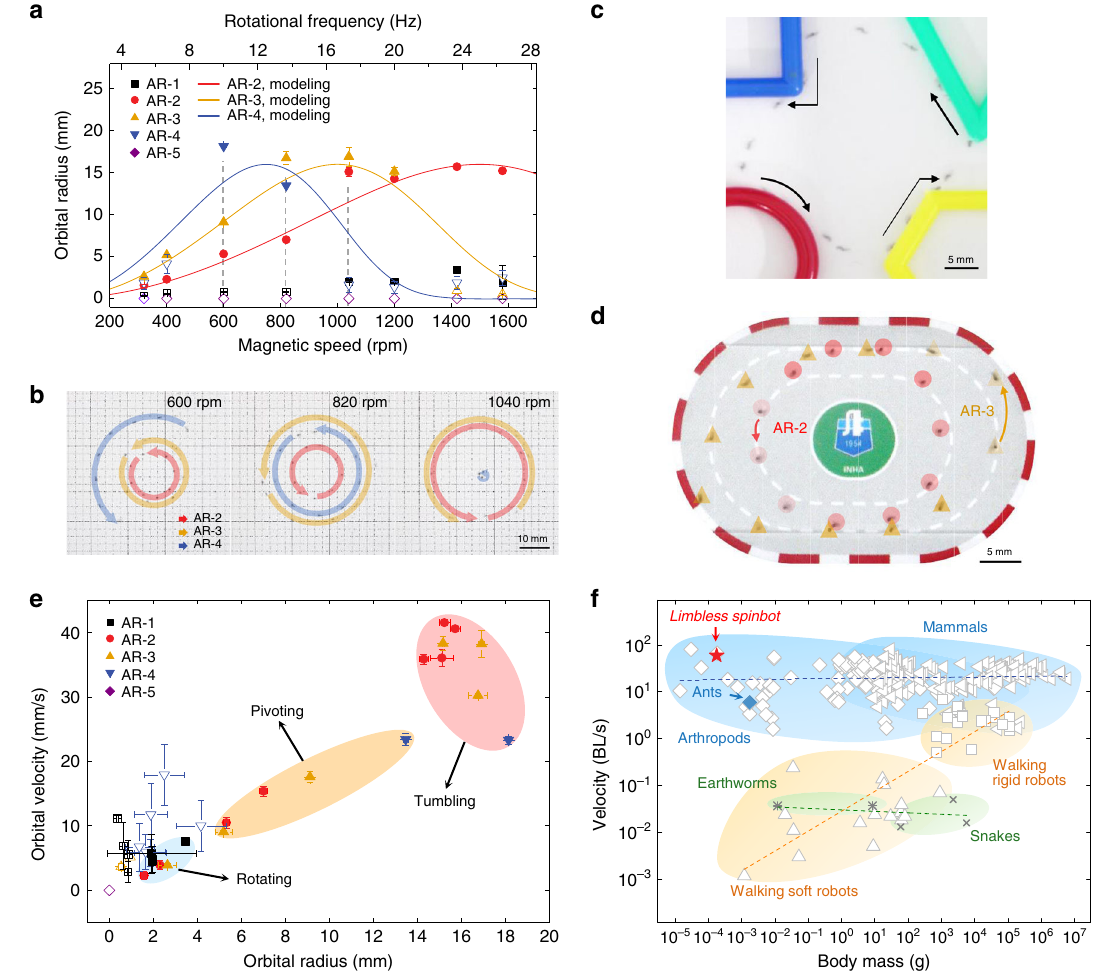
Fig. 3 Maneuverability and adaptability of the agile spinbot. a , b Orbital radius control of the single spinbot ( a ) and three soft robots with different AR ( b ). Open symbols indicate non-uniformly revolving motions. c , d Conformal navigation of the single spinbot through various boundary conditions such as rectangular, diagonal, and circular edges ( c ) and two spinbots through two linear barriers ( d ) at 1040 r.p.m. e Phase diagram for three rotational modes. The fastest velocity of the spinbot is 42 mm s − 1 in the tumbling mode. f Velocity normalized by the body length of the agile spinbot, walking soft robots, walking rigid robots, and living organisms. All error bars represent the standard deviation ( n =